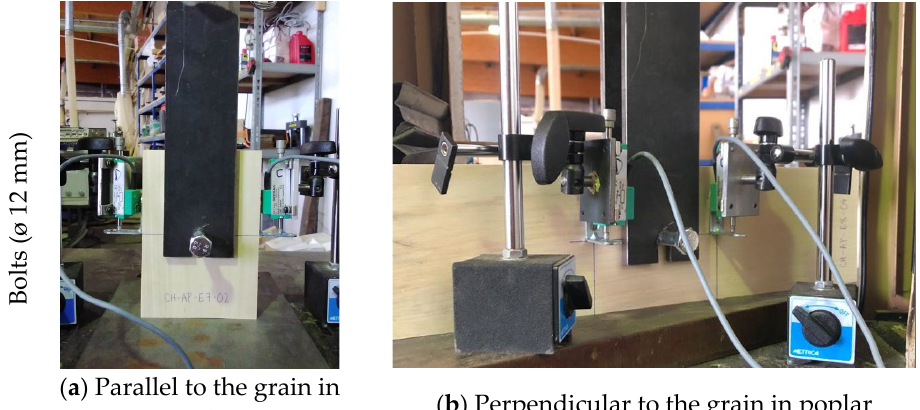
Figure 2. Experimental tests performed with screws.